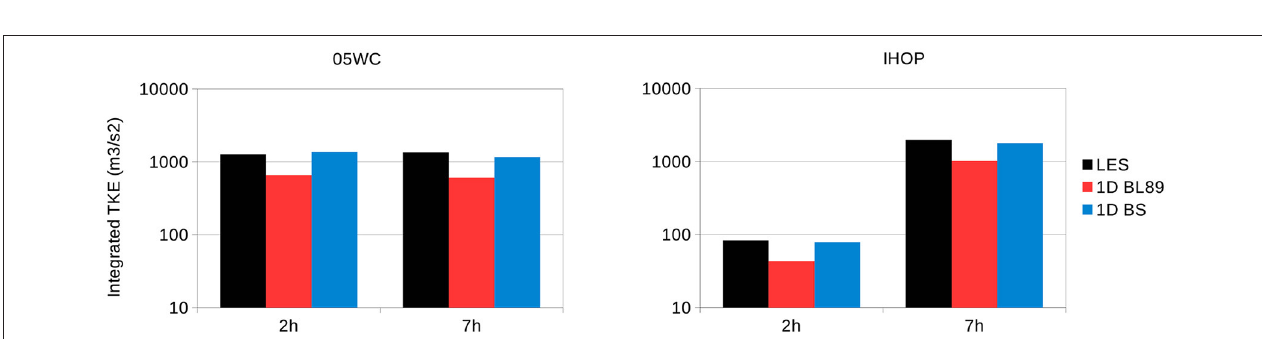
FIGURE 12 | Vertically integrated TKE (Equation 30) for the convective cases with strong shear 05WC (Left) and weak shear IHOP (Right) ; see Table 1 . Three runs are compared: the reference LESs, the original SCM (1D BL89), and the modified SCM with the new length scale (1D BS). The ITKE are computed 2 and 7 h after the start of the